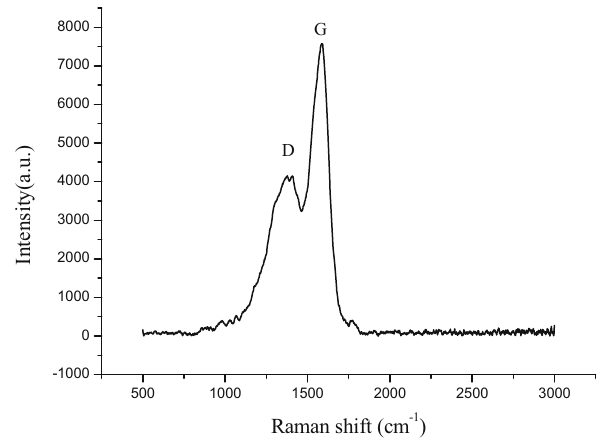
Figure 6: Raman spectrum of sample